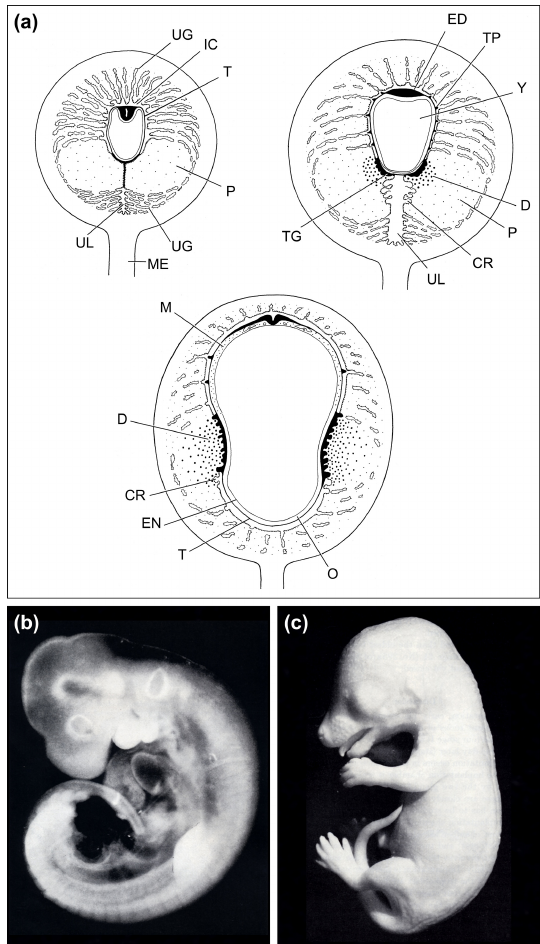
Figure 1. Implantation and embryonic development of Tupaia be- langeri . (a) At embryonic day (E) 7 (primordial amniotic cavity stage, top left scheme), the blastocyst resides in the implantation chamber (IC) and is initially attached to the antimesometrial (ME, mesometrium) surface of the two apposed endometrial pads (P). At the embryonic disc (ED) stage (E9, top right scheme), the implan- tation chamber opens. The now-separated endometrial pads exhibit endometrial crypts (CR) on the mesometrial half of their surfaces. At the neural groove stage (E9, lower scheme), the blastocyst is completely attached to the surface of the endometrial pads. The om- phalopleure (O) contacts the mesometrial pole of the uterine lumen. D, decidua; EN, endoderm; M, mesenchyme; T, trophoblast; TP, trophoblast plugs; UG, uterine glands; UL, uterine lumen; Y, yolk sac. (b) E14, total length: 4.14mm. (c) E29, total length: